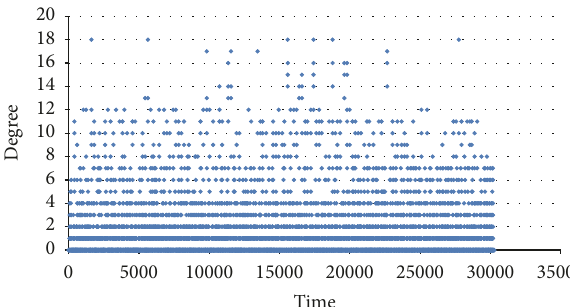
Figure 10: Degree of node 20 (developing schedule), throughout the simulation.